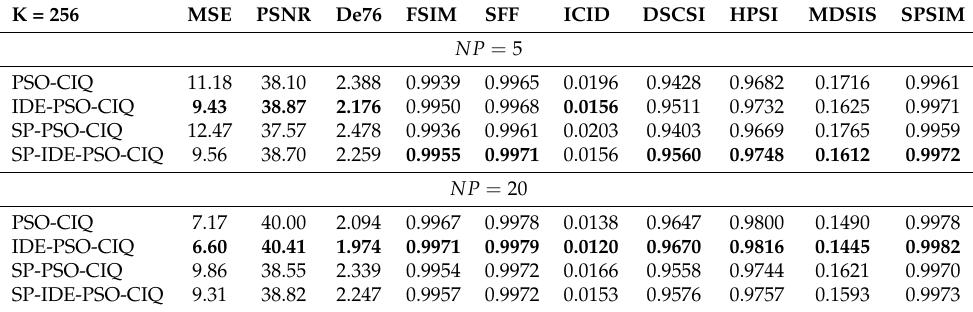
Table 5. Comparison of pixel and superpixel versions of PSO-CIQ and IDE-PSO-CIQ ( K =